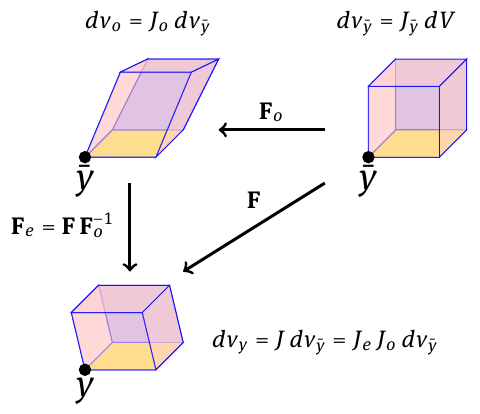
Figure 1: The essence of a distortion. The volume element dv ¯ y , attached to a point ¯ y ∈ B ¯ of the source configuration (top, right) is y mapped by F onto a distorted element dv , attached to the same o o point ¯ y (top, left). To get a compatible volume element dv (bottom, y left), we must add a further strain to F , called the elastic strain F . o e The embedding F is thus given by F = F e F o